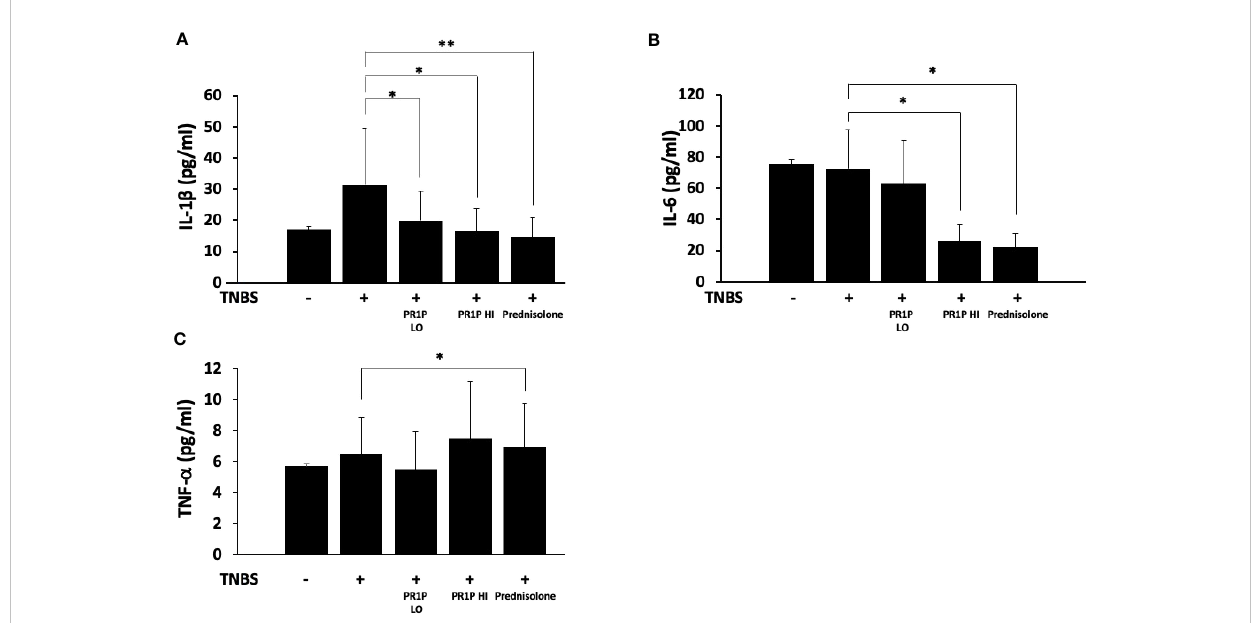
FIGURE 4 PR1P mediates in fl ammation in TNBS-induced colitis in rats. (A-C) Bar graphs showing quanti fi cation of IL-1 b ( A, *p<0.03, **p<0.003), IL-6 ( B, *p<0.0001) and TNF- a ( C, *p<0.04) in plasma on day 7 in rats treated with daily low-dose PR1P (0.5 mg/kg IP, PR1P-LO) or high-dose PR1P (5 mg/kg IP, PR1P-HI) or prednisolone (10 mg/kg) following induction of colitis from administration of intra-rectal TNBS. Control rats were treated with vehicle only. Data are mean ± SEM. n=8 animals per